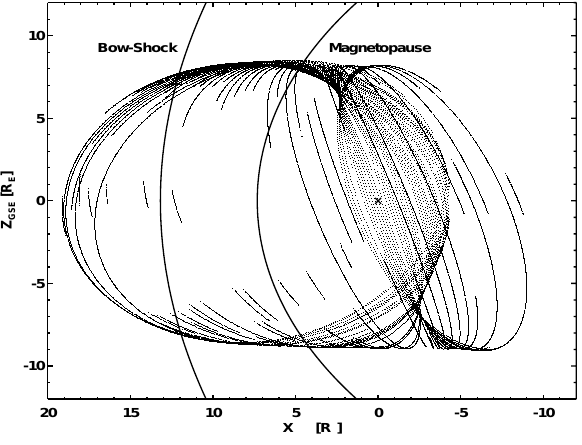
Fig. 1. Positions r B of the spacecraft between February and June 2002 displayed in the ( X GSE - Z GSE